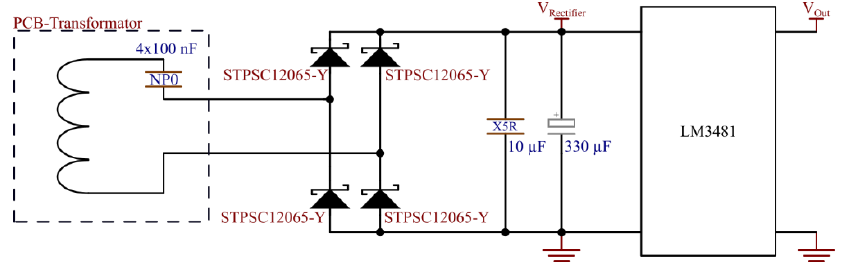
Figure 5. Circuit diagram of the voltage rectification and regulation on the secondary side of the isolated DC power supply with faster diodes and high efficiency boost converter.